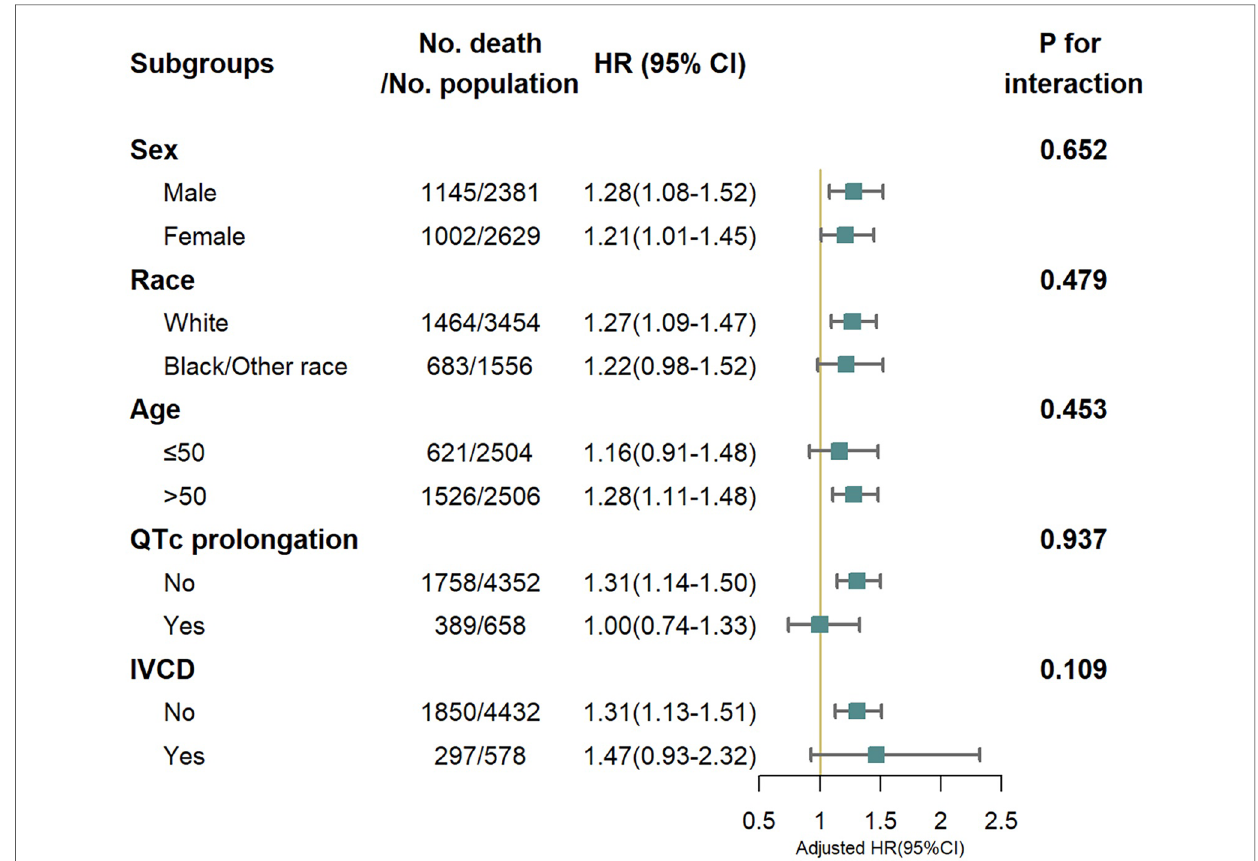
FIGURE 3 All-cause mortality risk in subgroup analysis. IVCD, Intraventricular conduction delay (bundle branch blocks or QRS>120 ms). Adjusted for age, sex, race/ ethnicity, income, body mass index, smoke, myocardial infarction, stroke, congestive heart failure, diabetes mellitus, family history of cardiovascular disease, antihypertensive medications use, HDL cholesterol, total cholesterol, diastolic blood pressure, systolic blood pressure, serum potassium, serum calcium, QRS duration, corrected QT interval and RR